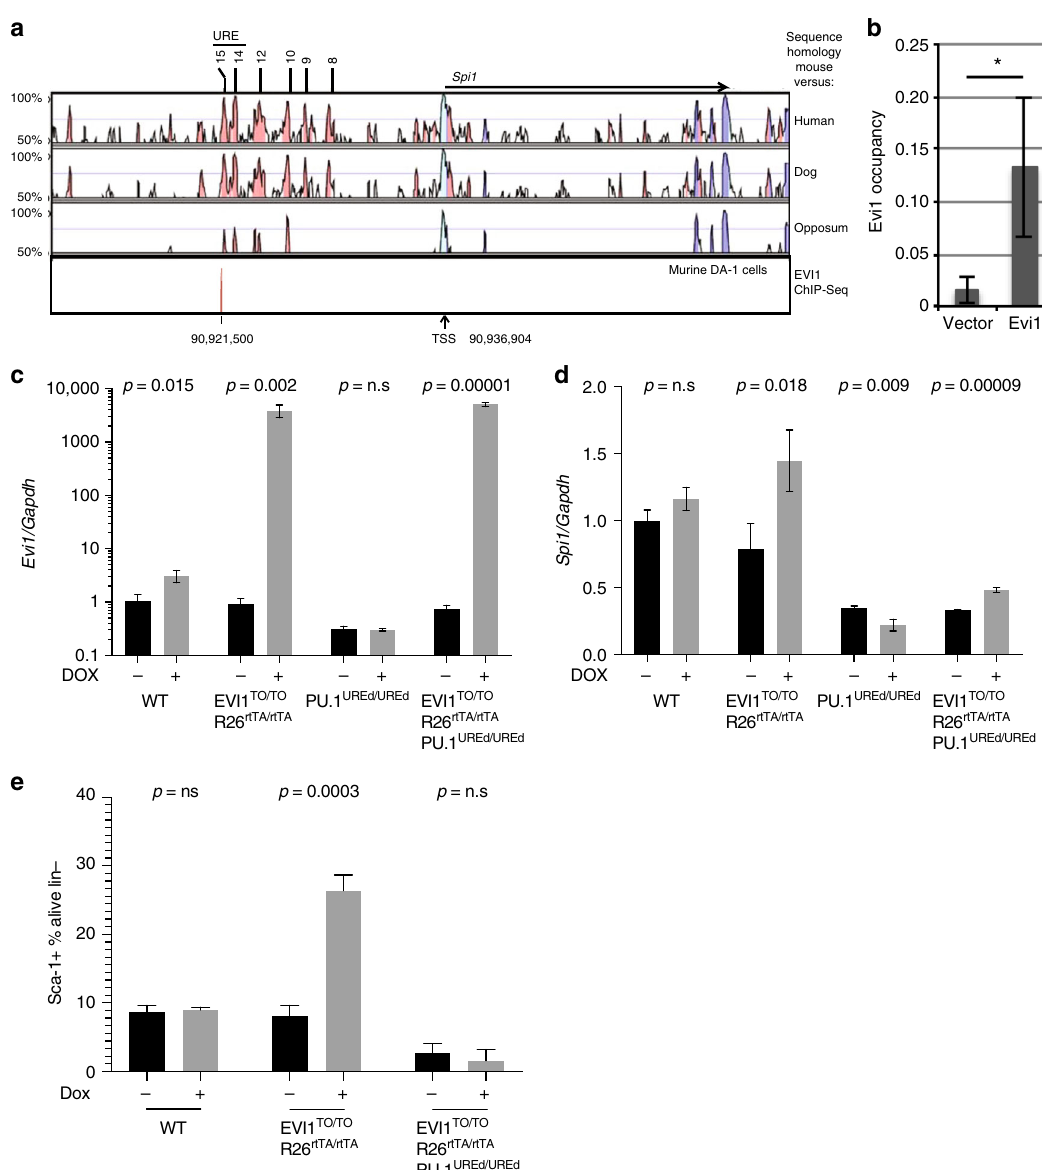
Fig. 7 EVI1 binds to the − 14kbURE of Spi1 and requires this element for Sca-1 upregulation. a Region of mouse genome encompassing the transcription start site (TSS) of Spi1 together with 25 kb of upstream DNA. Top three bands show peaks of sequence homology between mouse and human, dog, and opossum, as indicated, while the bottom band displays our ChIP-Seq for EVI1 occupancy in the murine myeloid leukemia cell line, DA-1, at − 15.45 kb from the Spi1 transcription start site. Also indicated is the location of the − 15 to − 14 kb upstream regulatory element, referred to in the text as − 14kbURE. b ChIP-qPCR data showing EVI1 occupancy at the Spi1 – 15.45 binding site in EML cells transduced with WT EVI1 or vector control. c , d RT-qPCR for Evi1 ( c ) or Spi1 ( d ) on Lin − bone marrow cells, with or without in vivo DOX treatment for 72 h from four genotypes of mice, harboring either Evi1 TO/TO Rosa26 rtTA/ rtTA or Spi-1 UREd/UREd genotypes, as indicated. e Quanti fi cation of Sca-1 + cells of WBM from mice with genotypes as indicated either with or without DOX treatment for 72 h ( n = 3). For all panels, error bars represent standard deviation; p values calculated with Student ’ s t